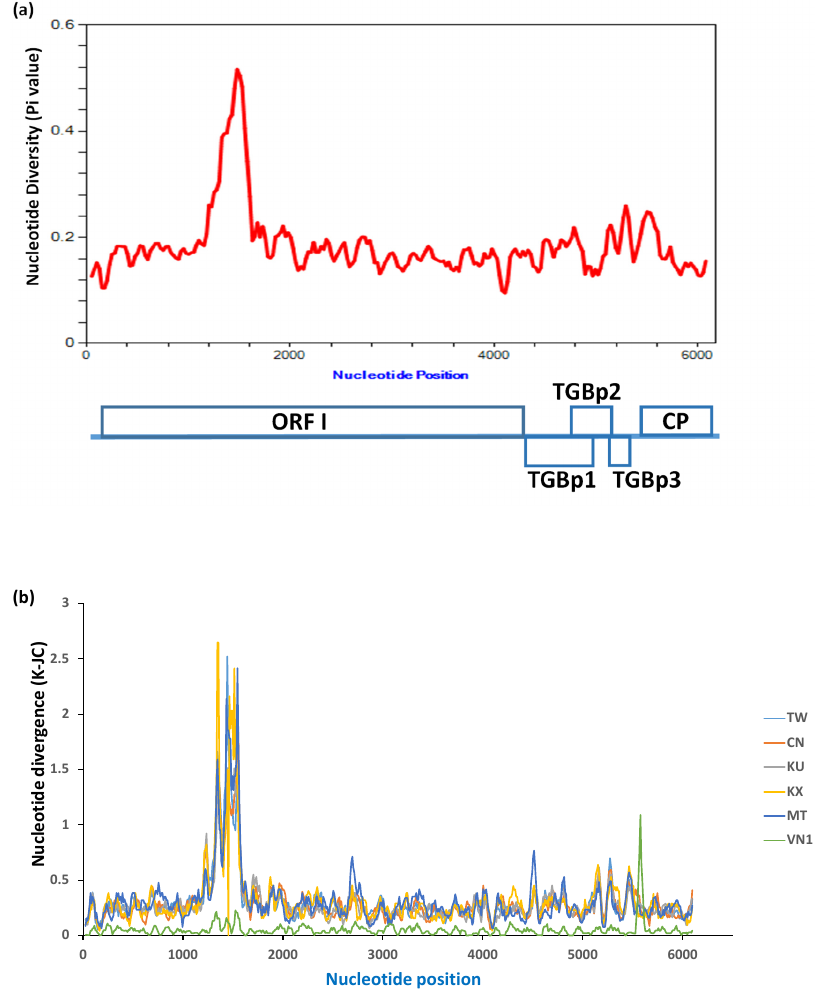
Figure 5. Analysis of nucleotide divergence of BaMV genome sequences. ( a ). Overall nucleotide diversity of genomic sequences of BaMV isolates. The average number of nucleotide differences per site between all possible pairs (Pi value) [41] of BaMV genomic sequences is plotted in the line chart. A sliding window of 100-nt in size and 25-nt in step was used to calculate the Pi value over the genomic sequences of 38 BaMV isolates (excluding BaMV-Au, GenBank accession number AB636267, which harbors an abnormally short ORF1 gene of only 1719 nucleotides in length that possibly resulted from artifacts in the sequencing process). A schematic representation of the BaMV genome depicting the approximate positions of each ORF is shown below. ( b ). Overall nucleotide divergence between BaMV-VN2 group and other BaMV groups. The nucleotide divergence with Jukes and Cantor correction (K-JC) values [41] between BaMV isolates in the VN2 group and those